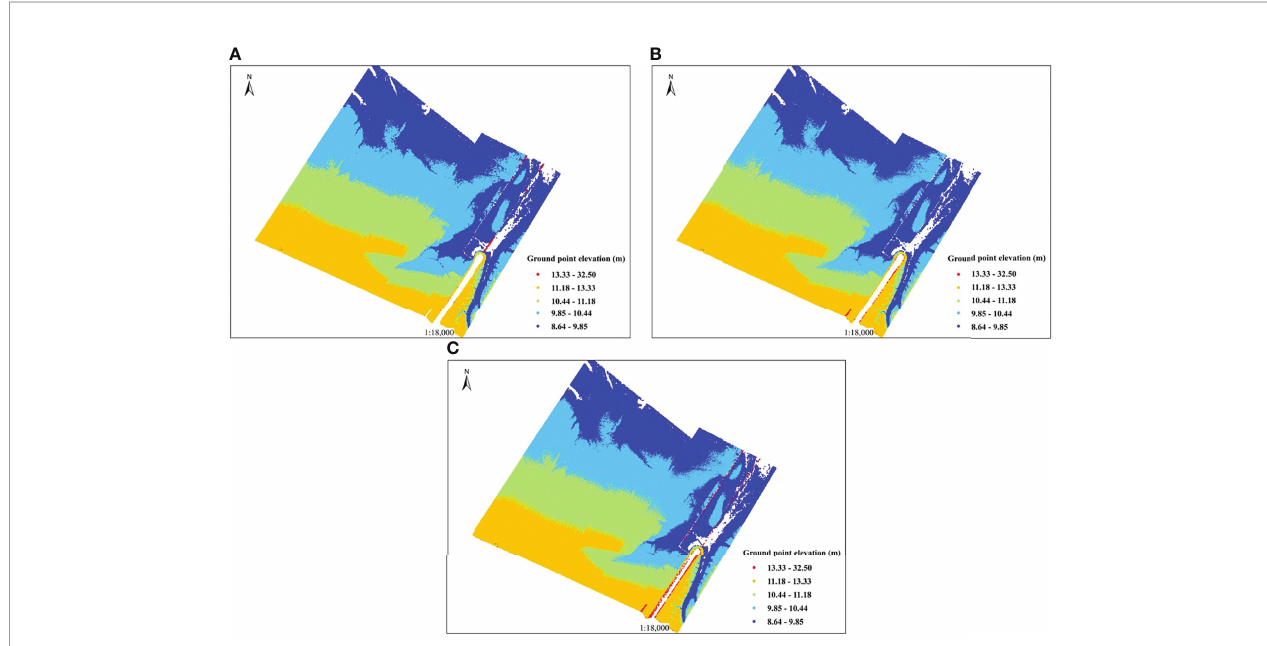
FIGURE 9 | The results of Mathematical morphology fi ltering (ground points) (A) ; Irregular Triangulation fi ltering (B) ; Point cloud normal vector fi ltering (C)